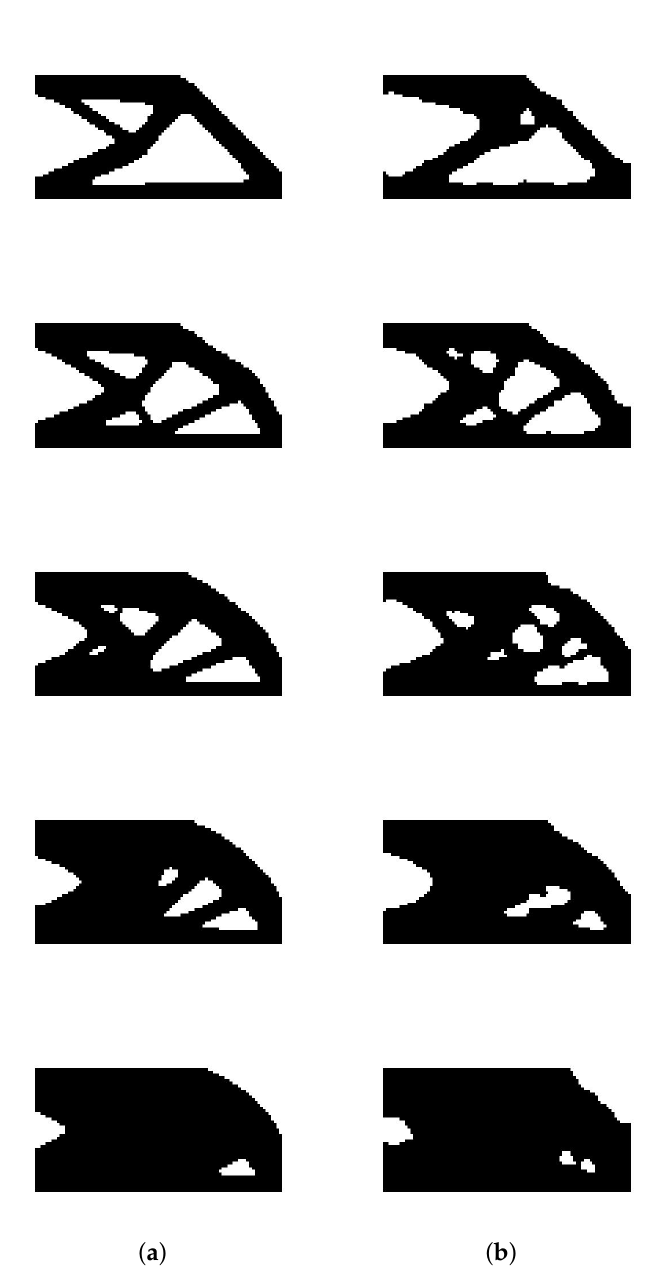
Figure 4. The results for optimized topology of cantilever beam in different volume fractions of 0.5, 0.6, 0.7, 0.8, and 0.9. ( a ) Results from the literature. ( b ) Results from the method proposed herein. Each variable has its crystallization factor and their value shows the crystallization of the variable as the temperature decreases. The value of the crystallization factor indicates if the variable is in an exploratory or refinement phase. Crystallization factors with higher values indicate that the variables are in the refinement phase. Crystallization factors with smaller values indicate that the variables are in the exploration phase. Four different variables were selected as shown in Figure 5a. The graph average of the crystallization factors for the four points per temperature is presented in Figure